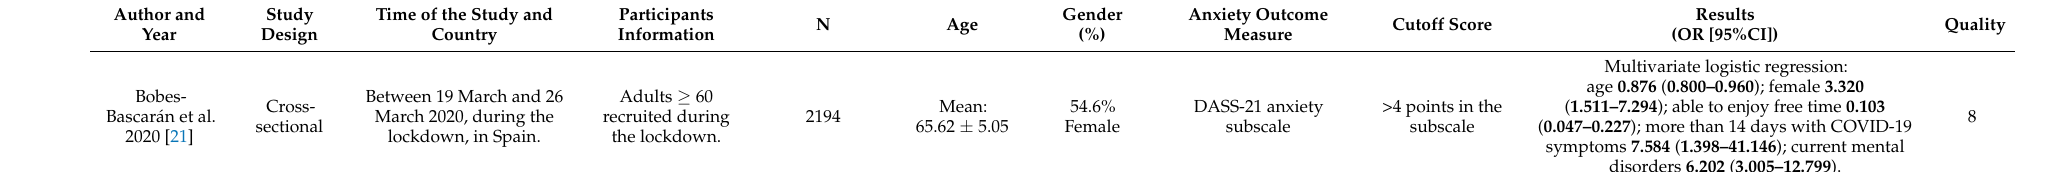
Table 2. Studies included that analyse factors associated with